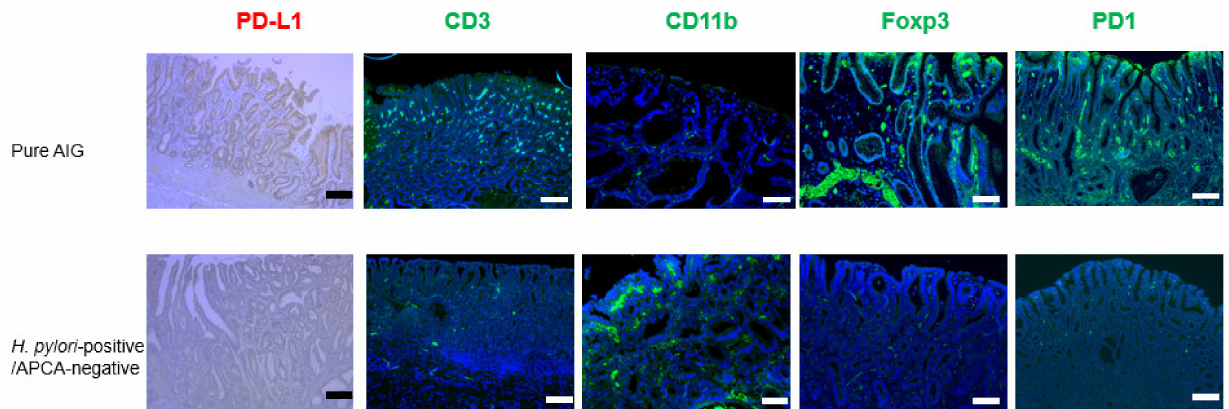
Figure 3. Hematoxylin-eosin and immunohistochemical staining for MUC2, MUC5AC, and MUC6 in gastric cancer in pure AIG and H. pylori /APCA-negative patients. High expression of MUC5AC and MUC6 in gastric cancer is associated with pure AIG. Scale bars, 200 µ m.